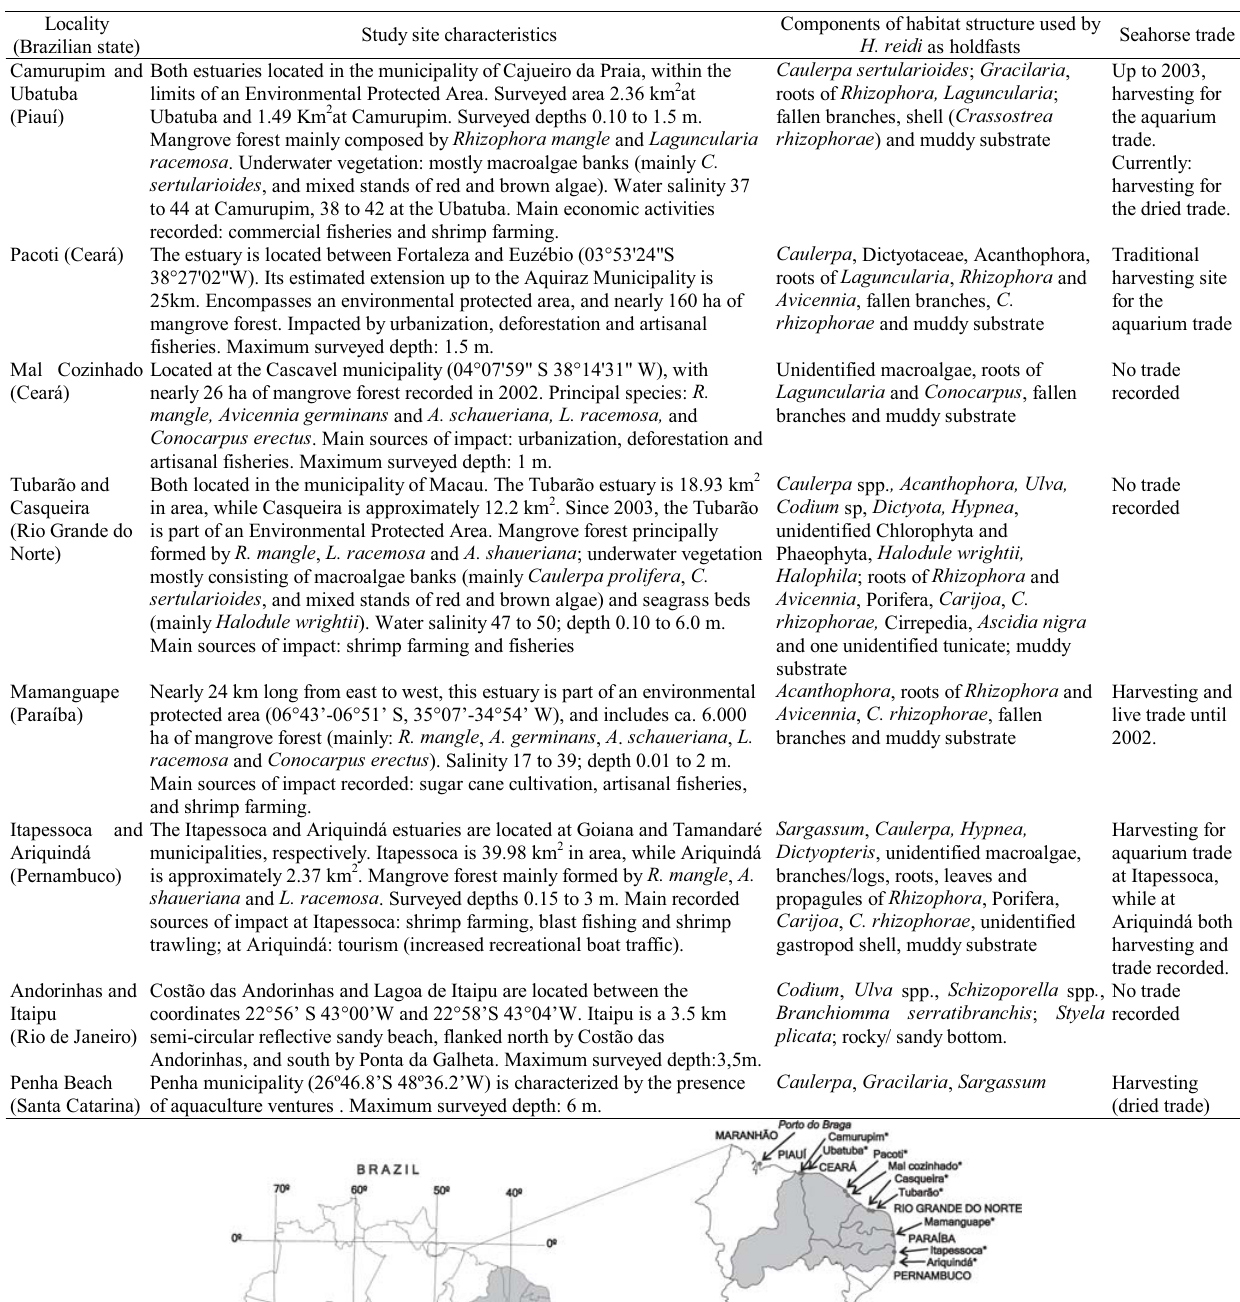
Table 1. Characterization of the surveyed